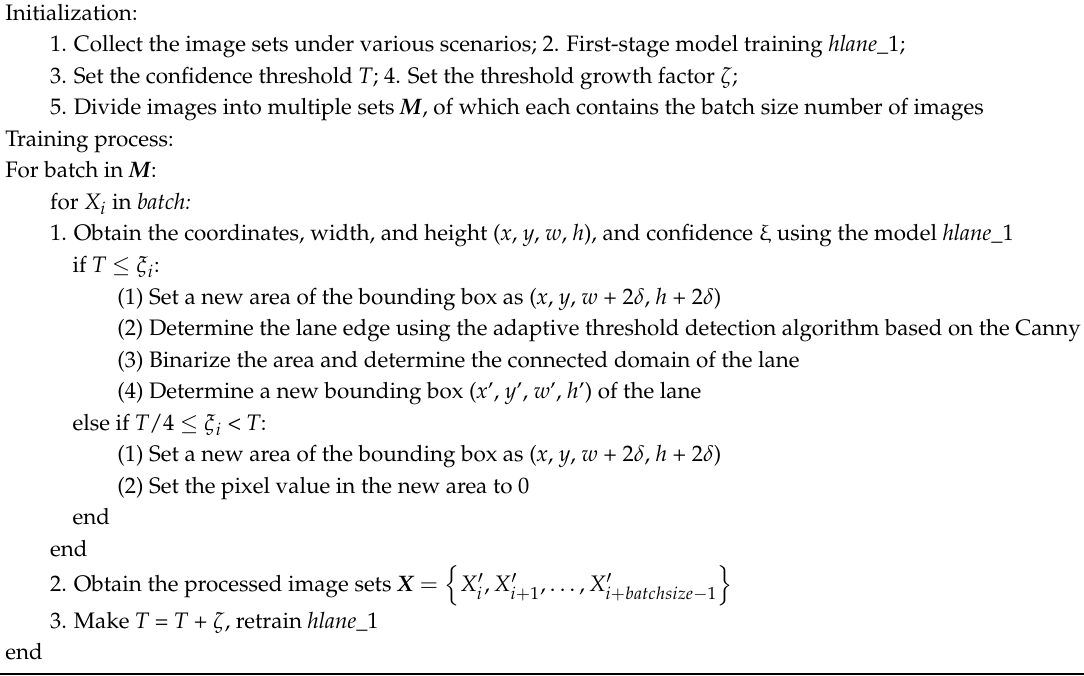
Algorithm 1 The second-stage model fine-training